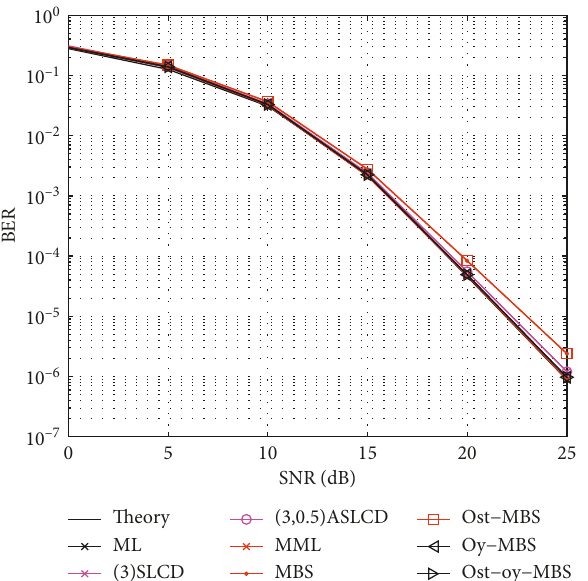
Figure 4: The BER performance of the proposed detectors with , N N T (cid:31) 8 R (cid:31) 4, and 16QAM modulation.